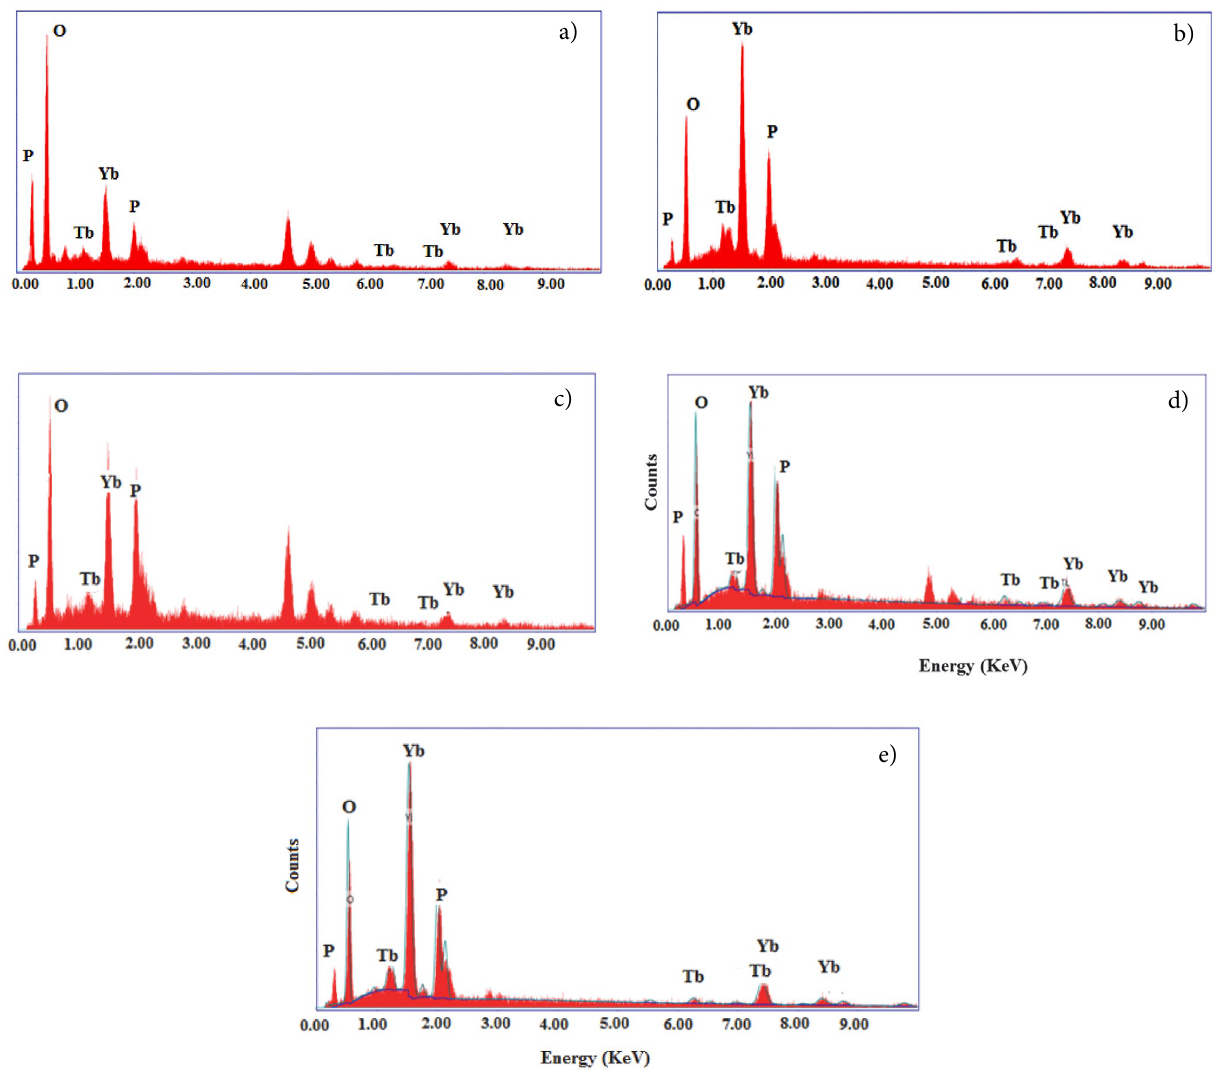
O. Table 1 represent the weight percent (Wt. %) and atom- ic percent (At. %) data for synthesized YbPO 4 :Tb 3+